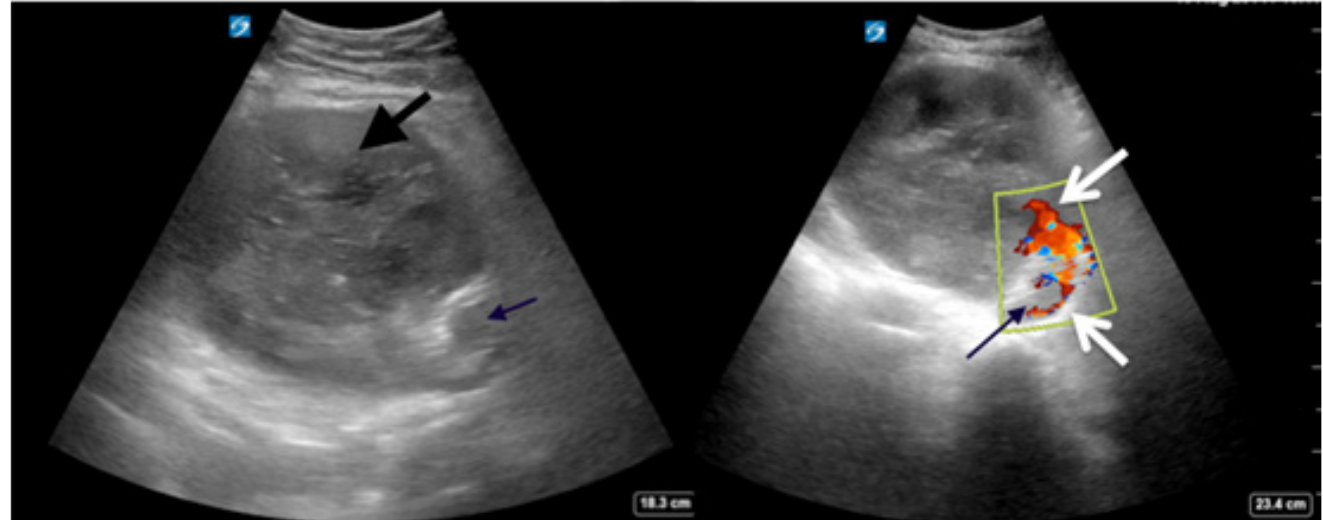
Figure. Ultrasound of the left iliac (left) with color Doppler flow (right) showing the true lumen (thin black arrow) and evidence of the leak (white arrows) creating a pseudoaneurysm (thick black